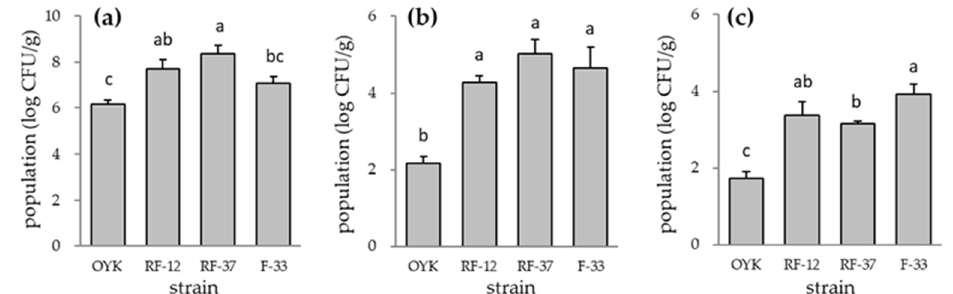
Figure 2. Colonization of seed-inoculated Bacillus sp. strains in the rhizosphere ( a ), root ( b ), and shoot ( c ) of the tomato plant. The tomato plant was cultivated using sterilized vermiculite, and colonization was examined at 24 days after seed inoculation. No colony appeared in the control samples. The bars represent the standard deviation (n = 4), and different letters indicate significant differences at p < 0.05 by Tukey’s test.